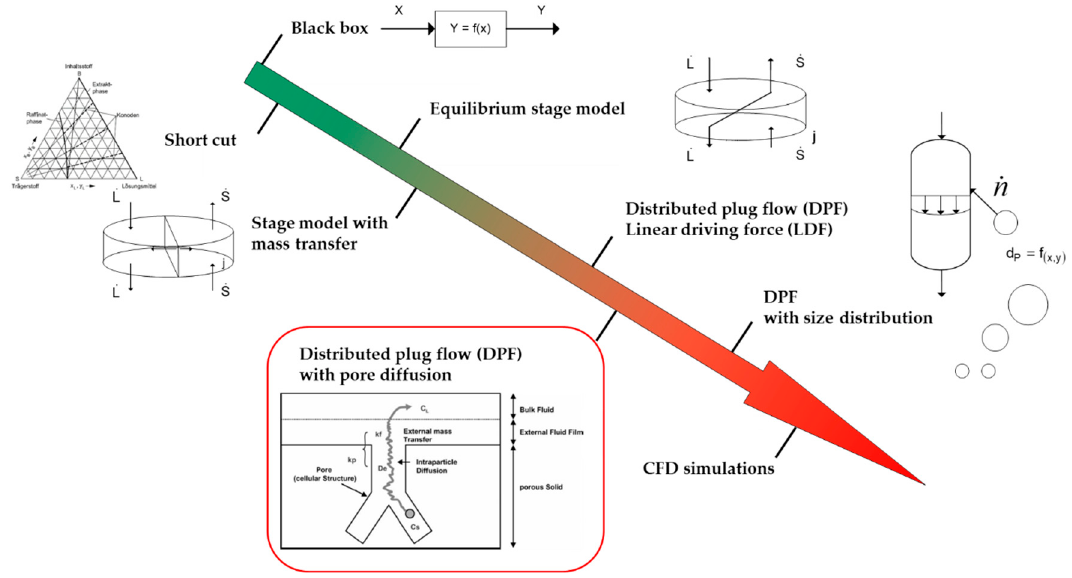
Figure 5. Di ff erent possible model depths. Adapted from Figure 5. Different possible model depths. Adapted from [25,26].